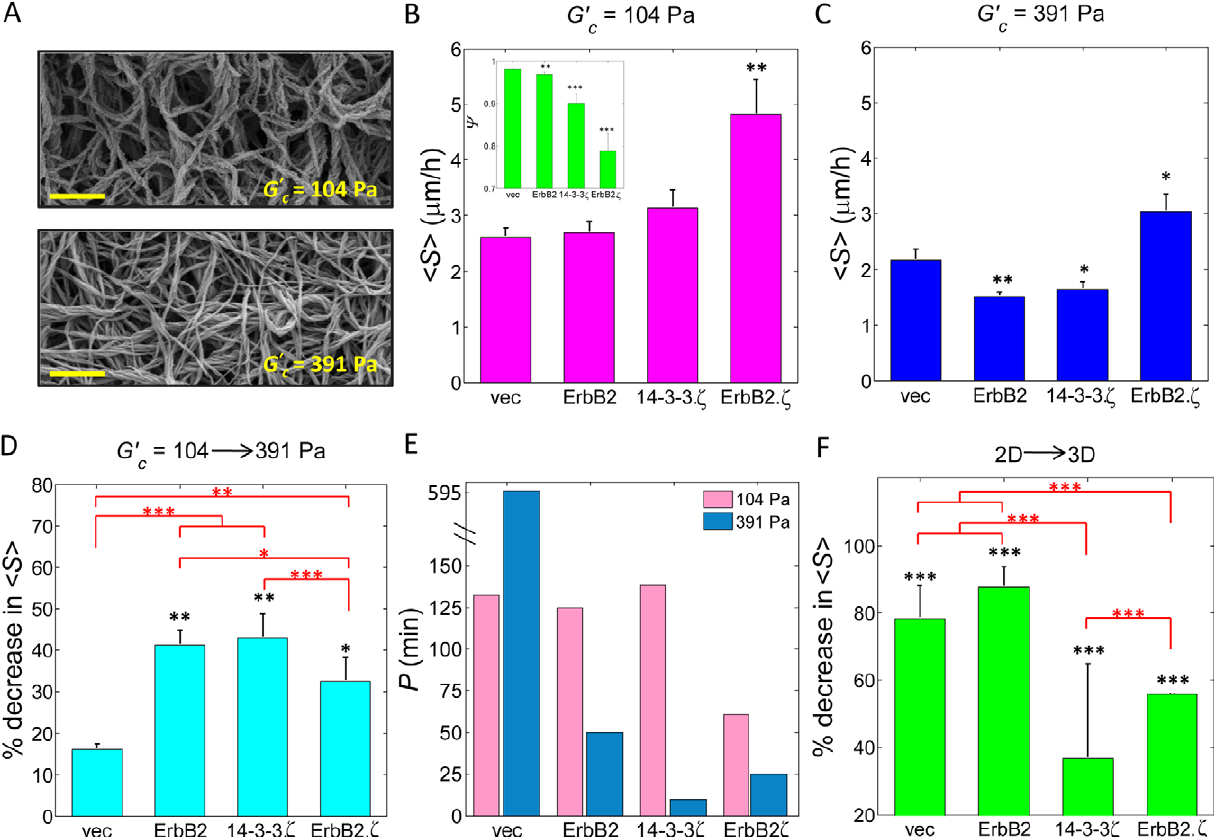
Figure 2. MCF10A cell motility in 3D matrices. ( A ) Scanning electron micrographs of compliant (104 Pa) and stiff (391 Pa) 3D matrices; scale bar is 2 m m. ( B ) Mean cell migration speed , S . in compliant 3D matrices. (Inset) cell sphericity Y as taken from Baker et al. [17]; p-values are with respect to , S . (and Y ) of 10A.vec cells. ( C ) Mean cell migration speed , S . in stiff 3D matrices; p-values are with respect to , S . of 10A.vec cells. ( D ) Percent decrease in , S . of cells within compliant matrices relative to cells in stiff matrices. The p-values shown in black reflect the difference in , S . between cells within compliant matrices and the same cells within stiff matrices; the p-values shown in red reflect the difference in % decrease in , S . among the sublines. ( E ) Cell population persistence time P in compliant and stiff 3D matrices (average R =0.87). ( F ) Percent decrease in , S . of cells atop 2D matrices relative to cells within compliant 3D matrices. The p-values shown in black reflect the difference in , S . between cells atop 2D matrices and the same cells within compliant 3D matrices; the p-values shown in red reflect the difference in % decrease in , S . among the sublines. All p-values (*,p # 0.05; **, p # 0.01; ***, p # 0.001) determined from t -tests for unpaired samples.